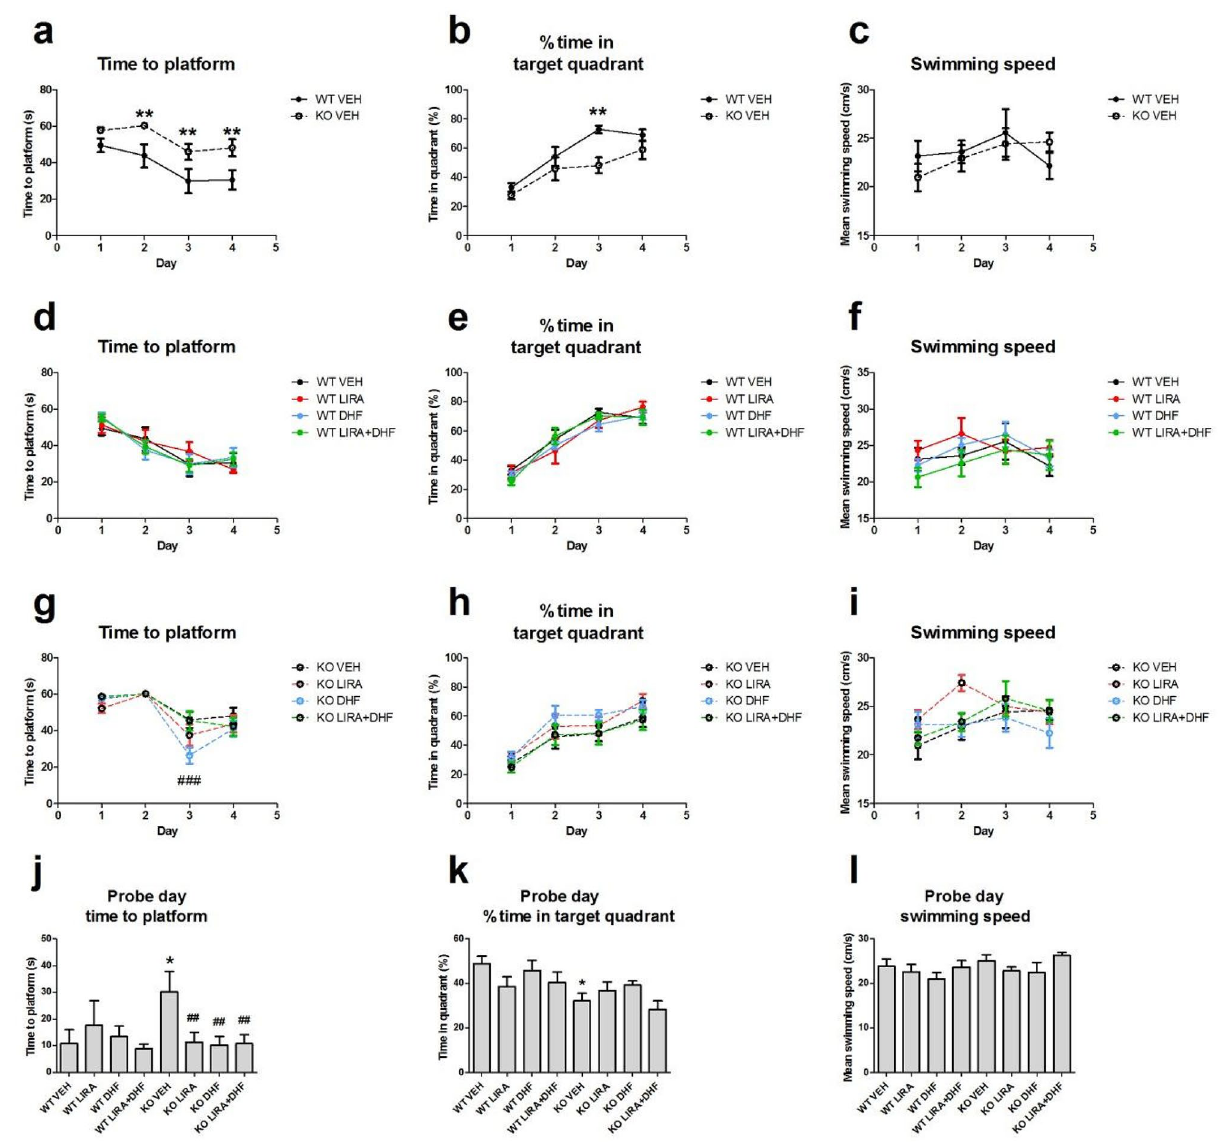
Figure 5. Evaluation of spatial learning of Wfs1 KO and WT rats using Morris water maze. Wfs1 KO animals took longer time than WT littermates to learn the position of the hidden platform ( a ). Similarly, Wfs1 KO rats spent less time in target quadrant than WT rats during training phase ( b ). Swimming speed was not different between genotypes ( c ). Pharmacological treatment with liraglutide (LIRA), 7,8-dihydroflavone (DHF) or their combination (LIRA + DHF) had no overall effect on performance of rats during learning phase ( d – i ). On probe day, time to reach the platform was increased for Wfs1 KO rats as compared to WT rats, treatment with liraglutide, 7,8-DHF or their combination improved performance during probe day ( j ). Time spent in target quadrant ( k ) during probe day was decreased in Wfs1 KO animals and swimming speed ( l ) during probe day was not affected by genotype or treatment. Data are presented as mean ± SEM, n = 5–8. Data are analyzed with repeated measures ANOVA followed by Fisher LSD post hoc test, *p < 0.05 and **p < 0.01 compared to WT vehicle treated animals, ##p < 0.01 , ### p < 0.001 compared to vehicle treated Wfs1 KO